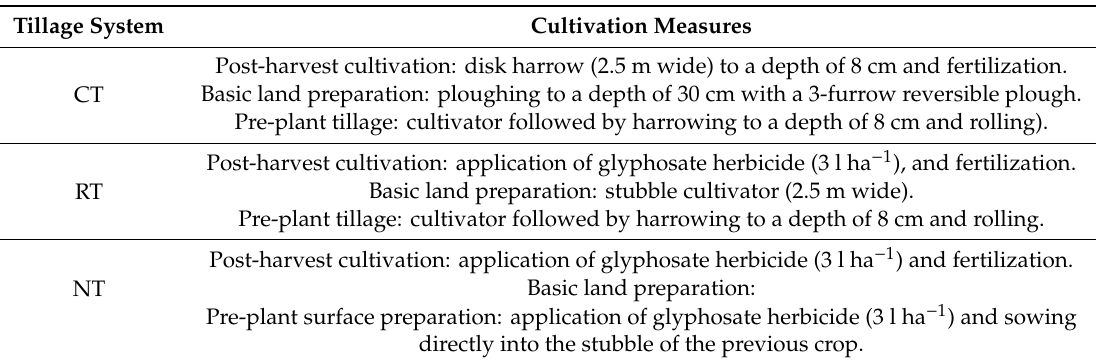
Table 3. Tillage